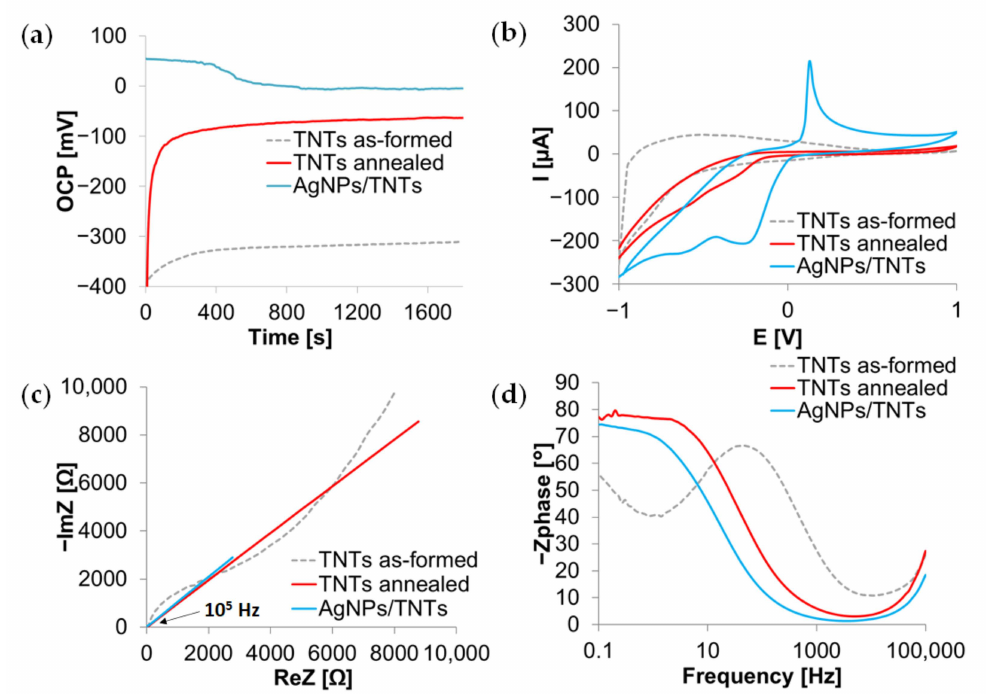
Figure 6. Open circuit potential curves ( a ), cyclic voltammograms ( b ), impedance spectra in Nyquist ( c ), and Bode ( d ) representation of as-formed TNTs, annealed TNTs, and AgNPs/TNTs platform, in PBS